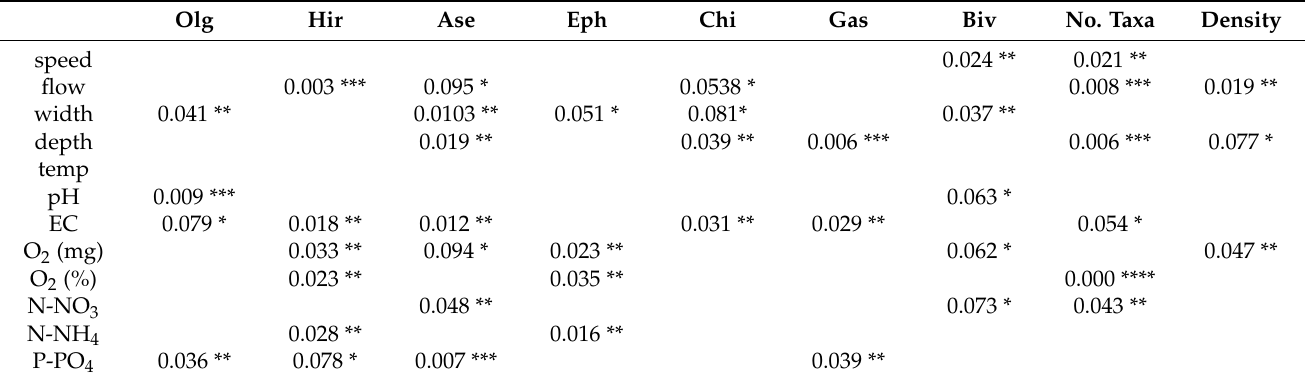
Table 6. Regression. Only statistically significant correlations are